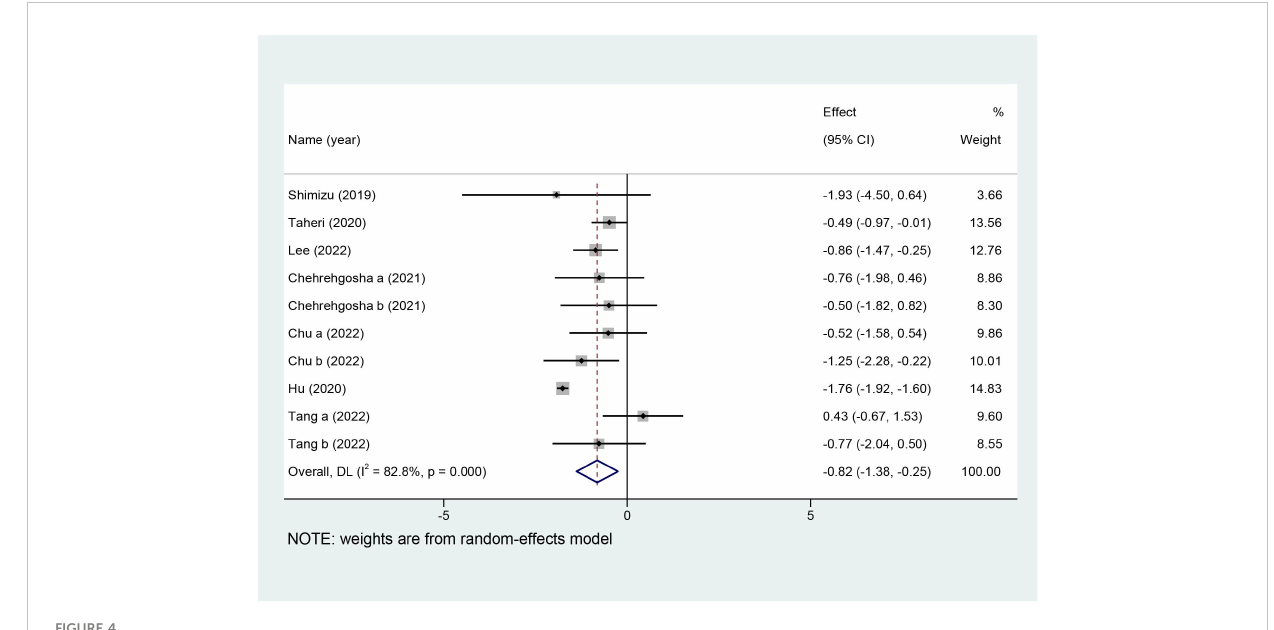
FIGURE 4 Forest plot of liver stiffness measurement (LSM).